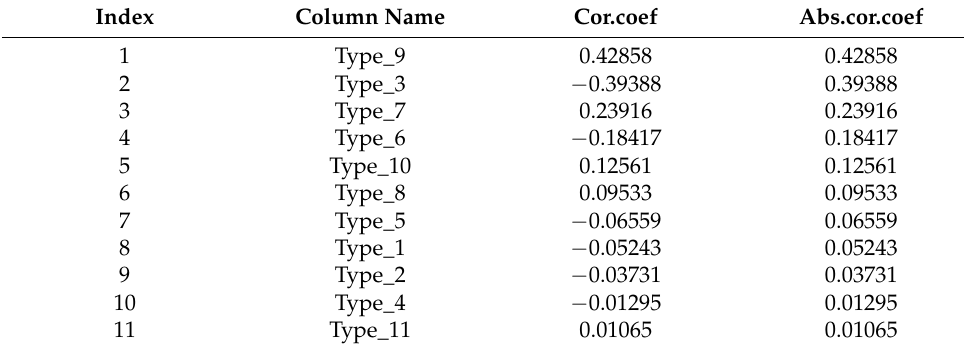
Table 5. Correlation coefficient for Building